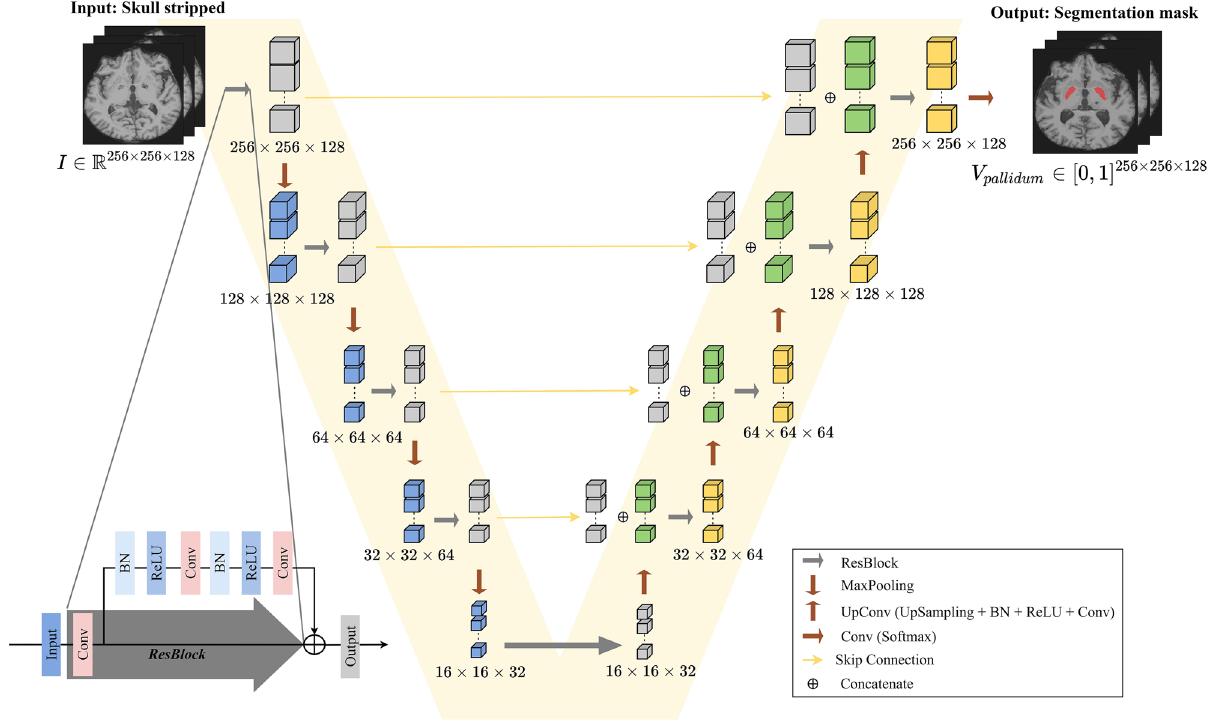
Figure 3. Architecture of CNN-based 3D segmentation using V-Net. ResBlock, MaxPooling, and UpConvolution were used to reduce the depth, height, and width. The output shown in the figure is the segmentation of pallidum. ( Conv convolution layer, BN batch